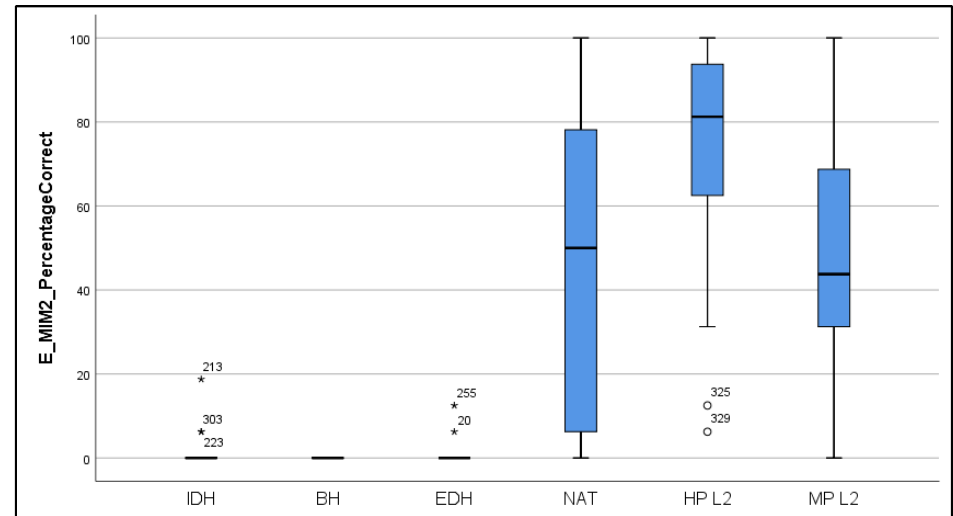
Figure 4. E-MIM Subtest 2 (N + Adj): Child and adult participants’ accuracy by language back- ground. IDH = Child, Irish-Dominant Home; BH = Child, Bilingual Home; EDH = Child, Eng- lish-Dominant Home; NAT = Adult L1/Native Speaker; HP L2 = Adult Highly Proficient L2 speaker; MP L2 = Adult Moderately Proficient L2 speaker. (* = extreme value).